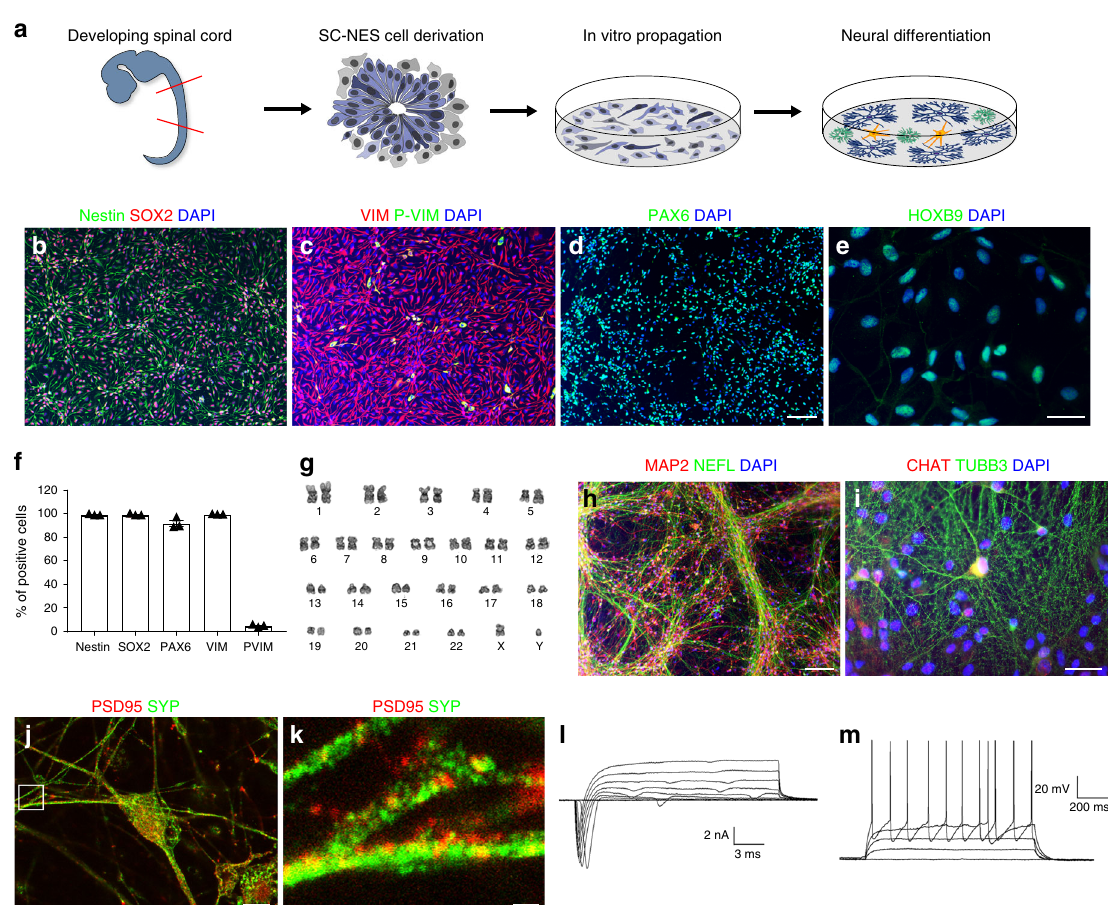
Fig. 1 Characterization of human NES cells in proliferation and after in vitro differentiation. a Schematics of the experimental procedure. SC-NES cells were derived from the SC of a human post-mortem specimen at 6 post-conceptional weeks (PCW) and propagated in vitro. After differentiation SC-NES cells give rise to neurons, astrocytes and oligodendrocytes. b – d SC-NES cells are positive for pan-neural stem cell markers nestin, SOX2, vimentin (VIM), phospho-vimentin (P-VIM) and PAX6. e SC-NES cells retain their regional identity as proved by the positive staining for the SC-speci fi c transcription factor HOXB9. f Quanti fi cation of nestin, SOX2, PAX6, VIM, P-VIM positive cells. g SC-NES cells retain a normal euploid karyotype after 25 passages. h , i Differentiation of SC-NES cells to MAP2-, TUBB3-, and neuro fi lament- (NEFL) positive neurons. SC-NES cells also generate choline acetyltransferase- (CHAT) positive neurons in agreement with their anatomical origin. j , k Mature neurons also express pre- and post-synaptic markers such as PSD95 and synaptophysin (SYP). l Total inward and outward ionic currents elicited at test potentials ranging from – 70 to + 40 mV from a holding voltage of – 90 mV. (M) Subthreshold and suprathreshold voltage responses to a family of injected steps of current (0 pA; 20 pA; 40 pA; 60 pA; 80 pA) from a resting potential of − 71 mV. Scale bars: b – d 100 µ m; e 20 µ m; h 100 µ m; m 20 µ m; j 10 µ m; k 1 µ